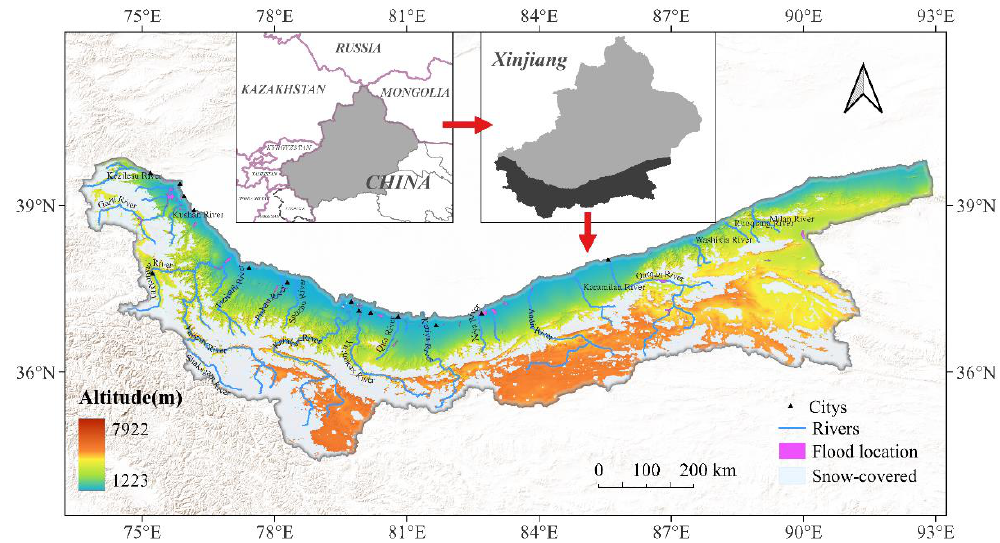
Figure 1. Locations of the study area and historical snowmelt floods.